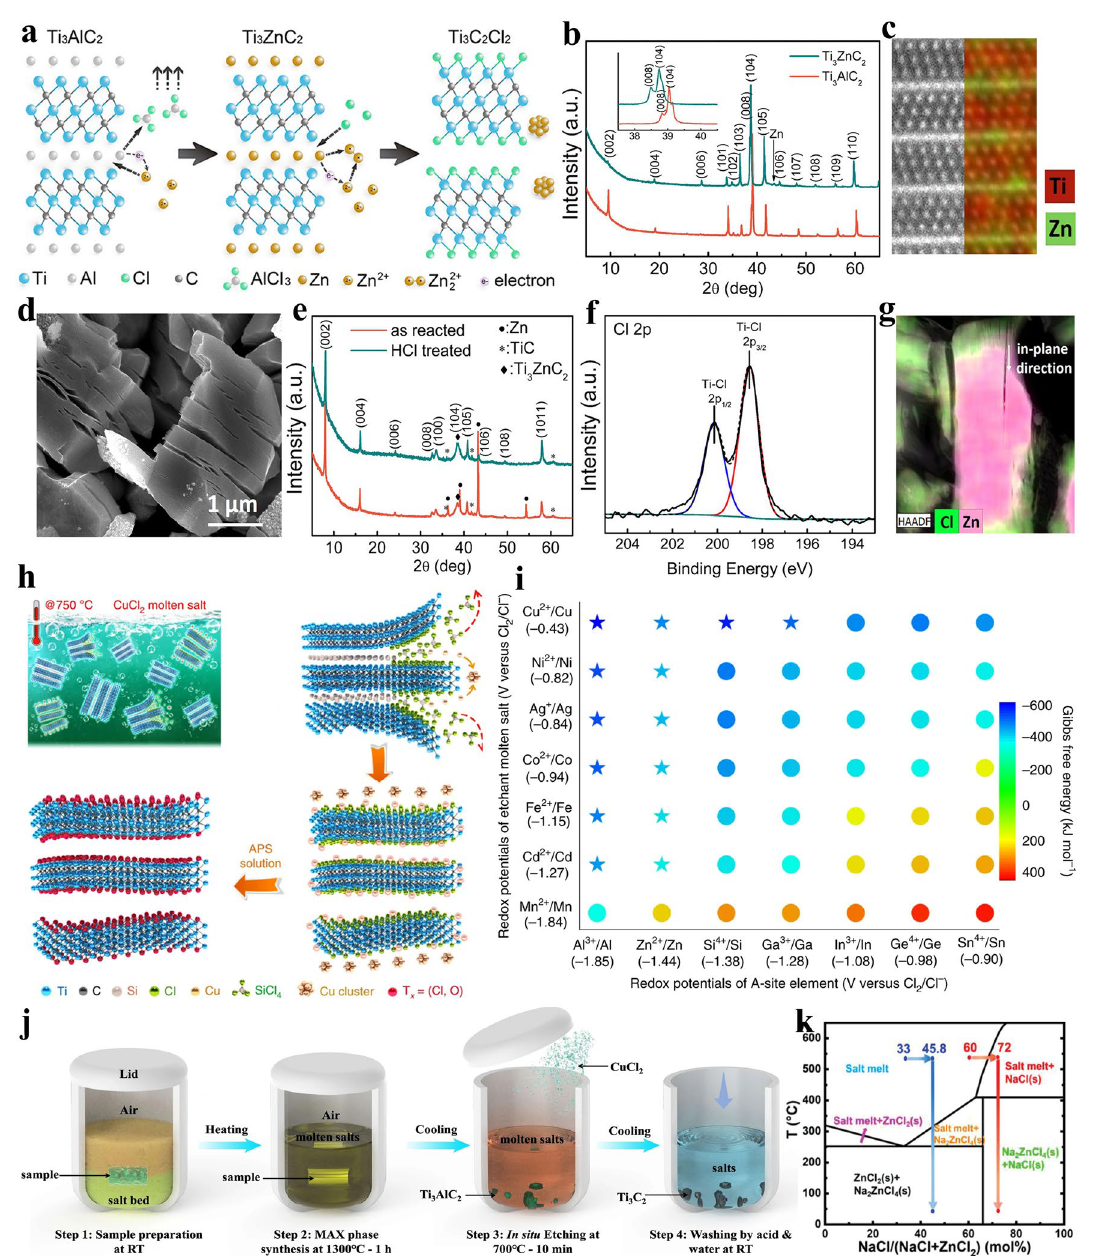
Fig. 6 a Schematic showing the preparation of Ti 3 C 2 Cl 2 MXene by ZnCl 2 Lewis acidic salt etching. b XRD patterns of Ti 3 AlC 2 and Ti 3 ZnC 2 MAX. c HAADF-STEM image of Ti 3 ZnC 2 MAX and corresponding energy-dispersive spectroscopy (EDS) mapping. d SEM image of multi- layered Ti 3 C 2 Cl 2 MXene. e XRD patterns of Ti 3 C 2 Cl 2 MXene and Ti 3 C 2 Cl 2 /Zn hybrids. f Cl 2 p XPS spectra of Ti 3 C 2 Cl 2 MXene. g EDS map- ping analysis showing the Lewis acidic etching of Ti 3 AlC 2 MAX. Reproduced with permission from [66] Copyright 2019, American Chemical Society. h Schematic demonstrating the preparation of Ti 3 C 2 T x MXene by CuCl 2 etching. i Schematic showing the relationship between redox potential of A-site elements, redox potential of Lewis acidic salts and Gibbs free energy. Reproduced with permission from [67] Copyright